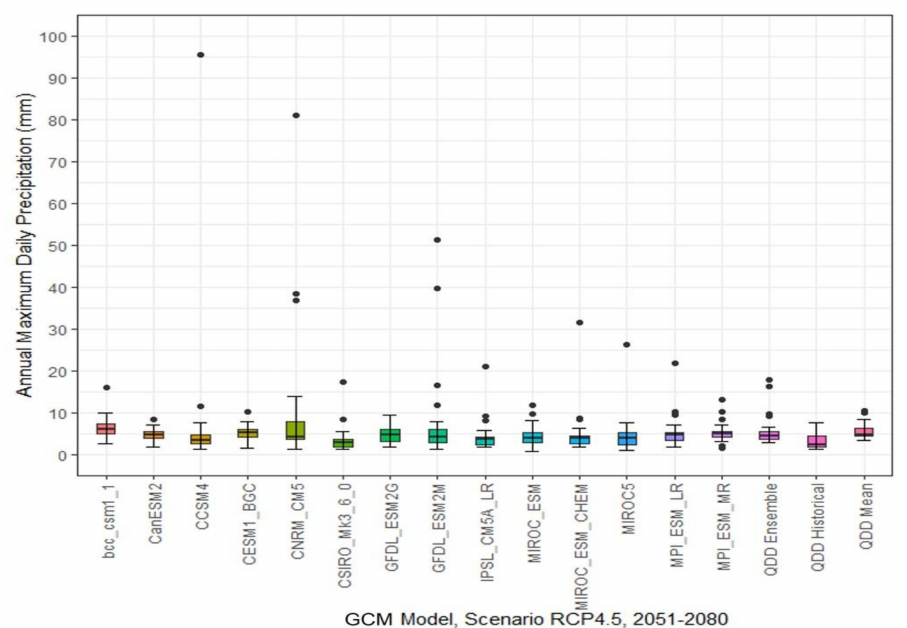
Figure 17. Boxplot for future projections of the annual maximum daily precipitation of 14 GCMs under the RCP4.5 scenario in the Devil’s Creek, period 2051–2080. The linear extensions represent the highest and lowest values; the upper, middle and lower limits of the box represent the percentiles of 75%, 50%, and 25%, respectively; and the solid circles represent the